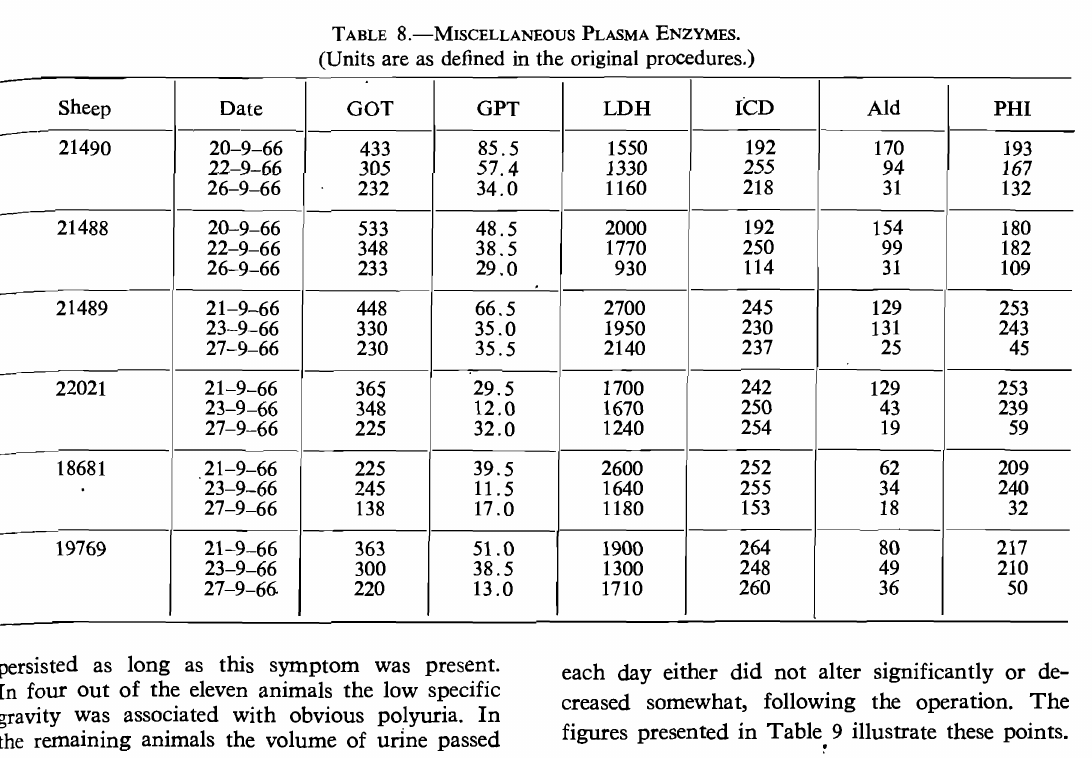
figures presented in Table~ 9 illustrate these points. TABLE 1O.-PLASMA PROTEINS (All values are expressed in g/;;. TPP = total plasma proteins; Alb = albumins; aI, a2, ~ and y refer to the globulin fractions. andy-Tis the trailing fraction. 10 The first date under each sheep is the date immediately after that of operation.) Sheep